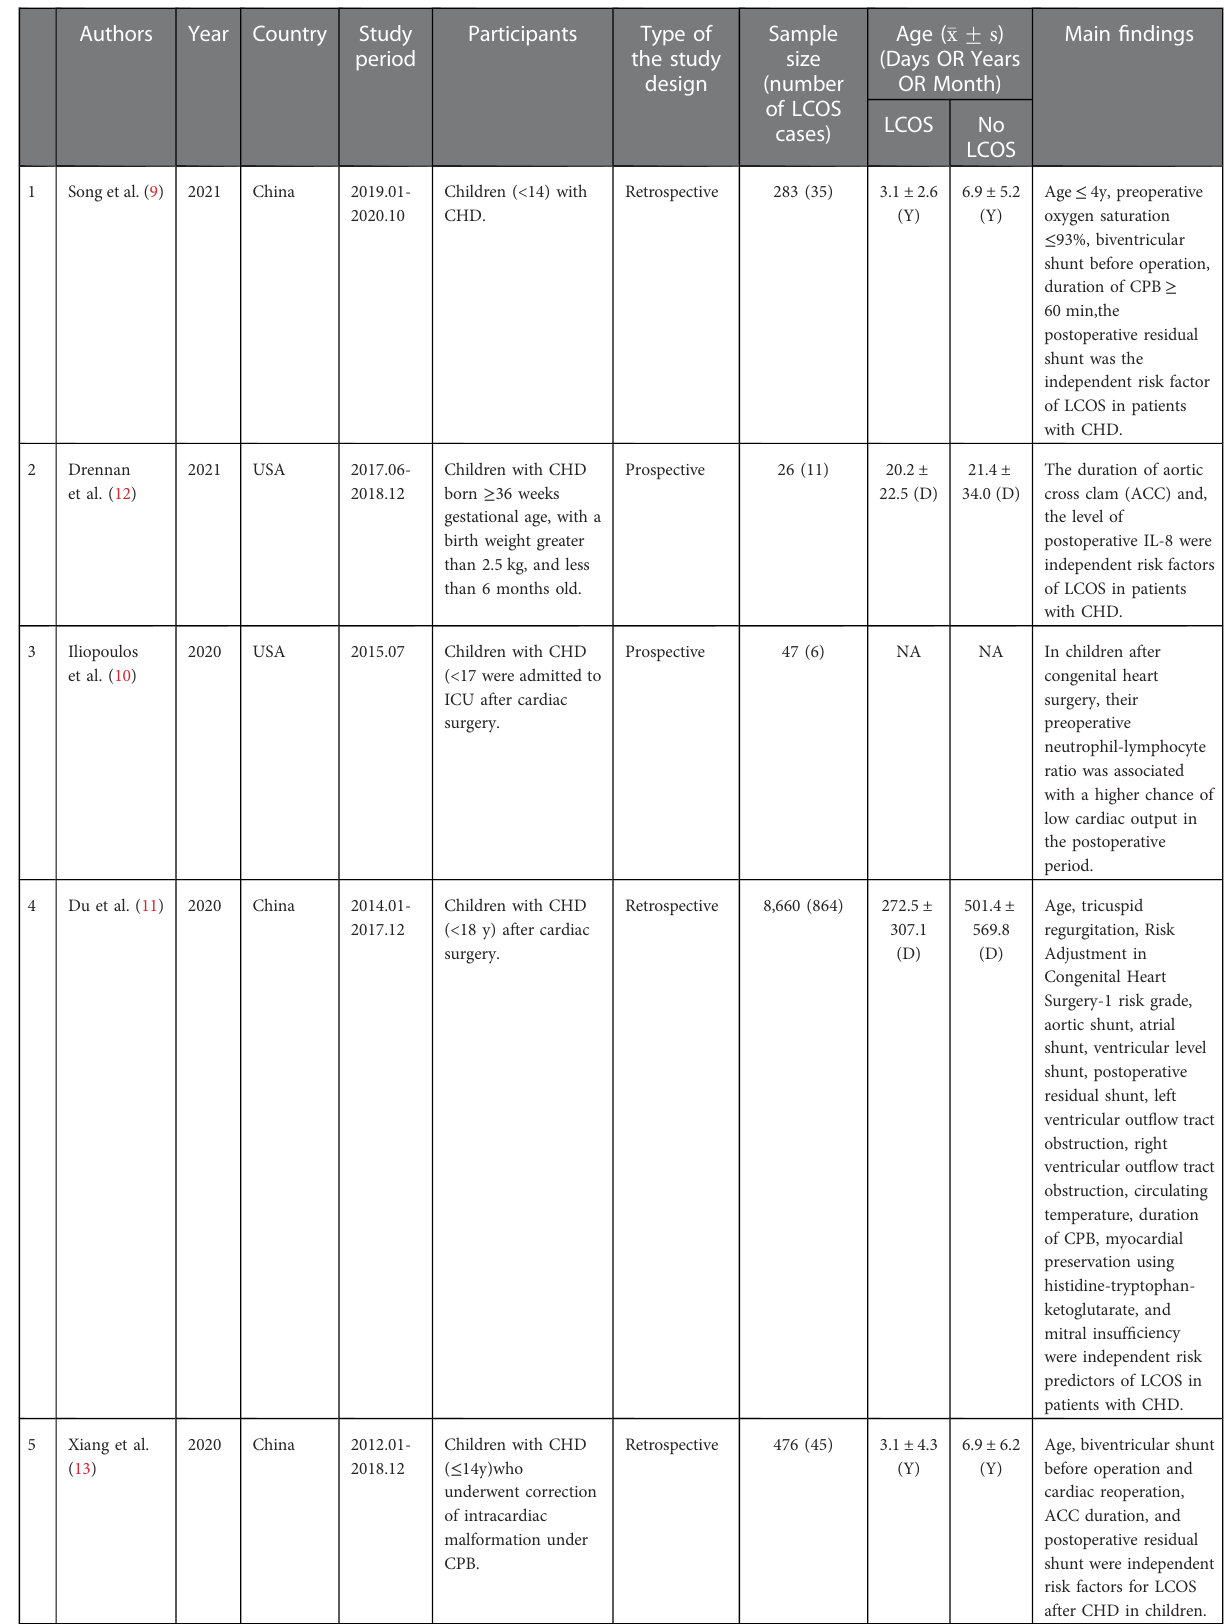
TABLE 1 Characteristics of the included